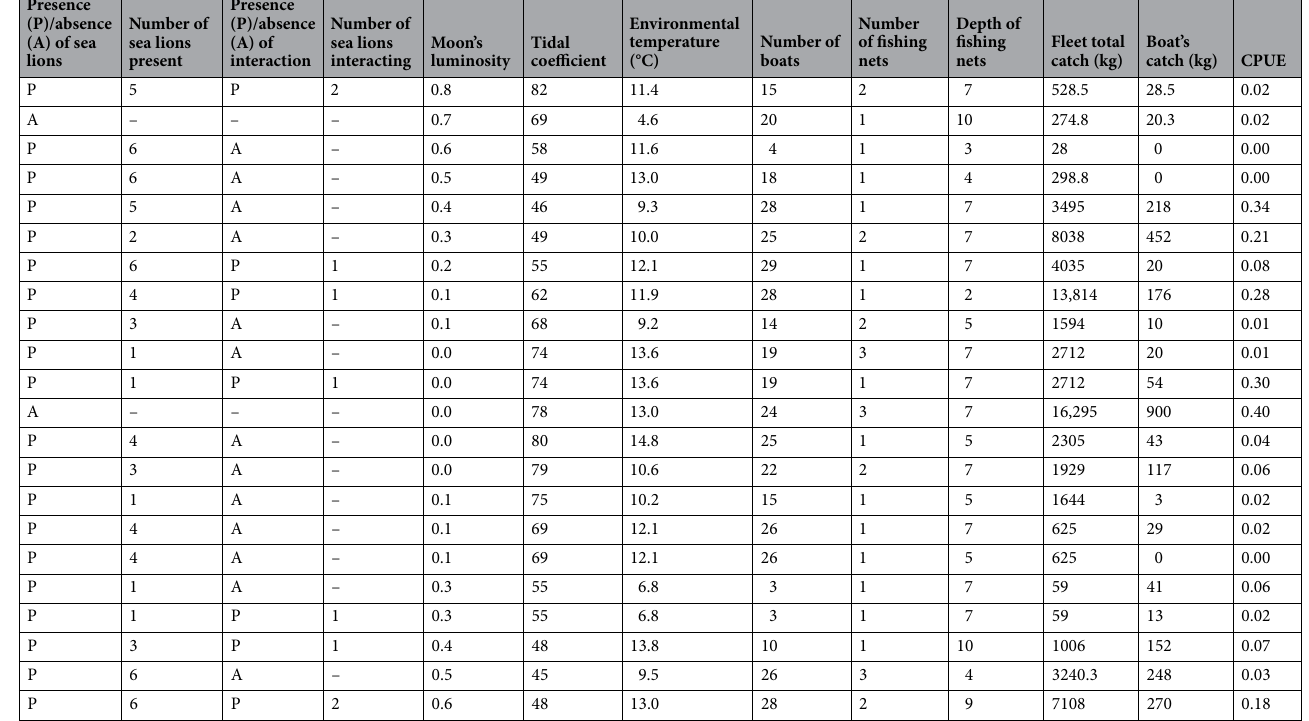
Table 2. Dataset of variables registered during fishing